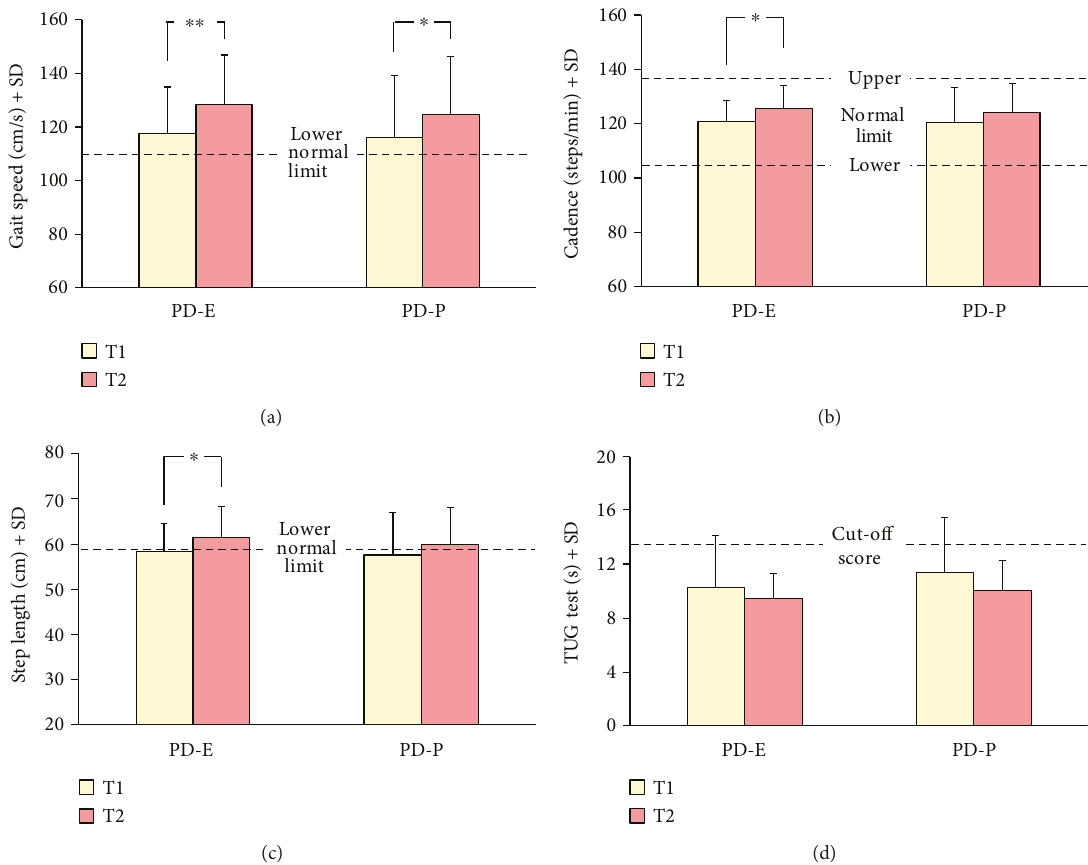
Figure 5: Analysis of the training e ff ects assessed by the baropodometric and clinical measures collected in the two groups at baseline (T1, yellow columns) and after the treatment (T2, pink columns). Gait speed (a) signi fi cantly improved in both groups, while cadence (b) and step length (c) increased only slightly (signi fi cantly so in PD-E). Dashed lines indicate the limits of normality. Time to perform the TUG test (d) slightly diminished in both groups; cut-o ff score for fall risk is indicated by the dashed line. Asterisks ( ∗ p < 0 05 ; ∗∗ p < 0 005 , Tukey ’ s post hoc test) indicate di ff erences within group. No di ff erence was found between groups after training for any variable